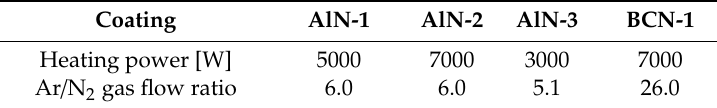
Table 1. Deposition parameters of the AlN and BCN thin